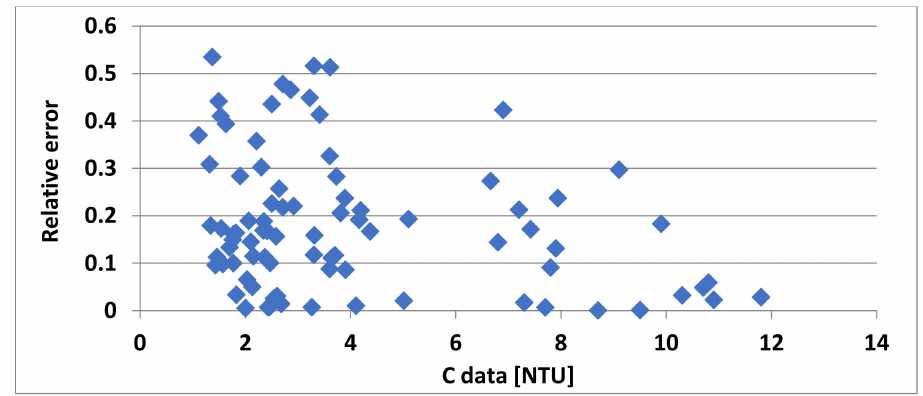
Figure 26. Model relative errors for turbidity versus measurement